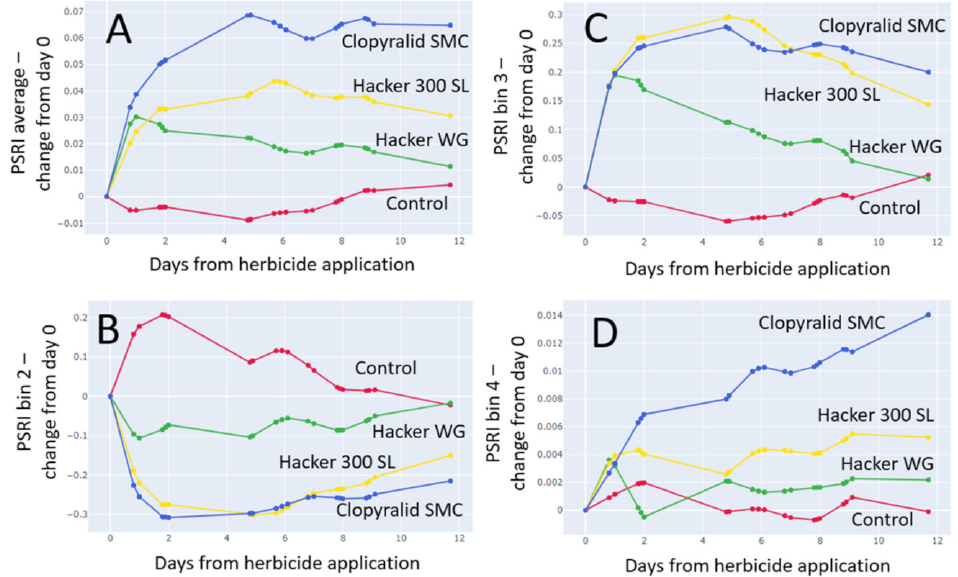
Figure 8. Dynamics of changes in the PSRI (plant senescence reflectance index) of cocklebur treated with various herbicides and Control plants. ( A ) Average PSRI of the plants after subtraction of the initial values at the time of the herbicide treatment. ( B ) Fraction of leaves with PSRI in the range − 0.5 to 0 (“bin 2”—healthy leaves) after subtraction of the initial values at the time of the herbicide treatment. ( C ) Fraction of leaves with PSRI in the range 0–0.5 (“bin 3”—stressed leaves) after subtraction of the initial values at the time of the herbicide treatment. ( D ) Fraction of leaves with PSRI in the range 0.5–1 (“bin 4”—strongly damaged leaves) after subtraction of the initial values at the time of the herbicide